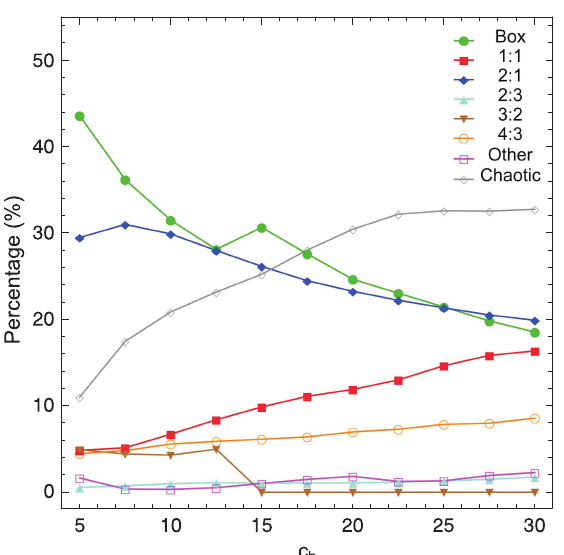
Fig. 6. Evolution of the percentages of different types of orbits in the phase plane ( R; ˙ R ) of our galaxy model, when varying the value of the scale length of the dark halo c h .